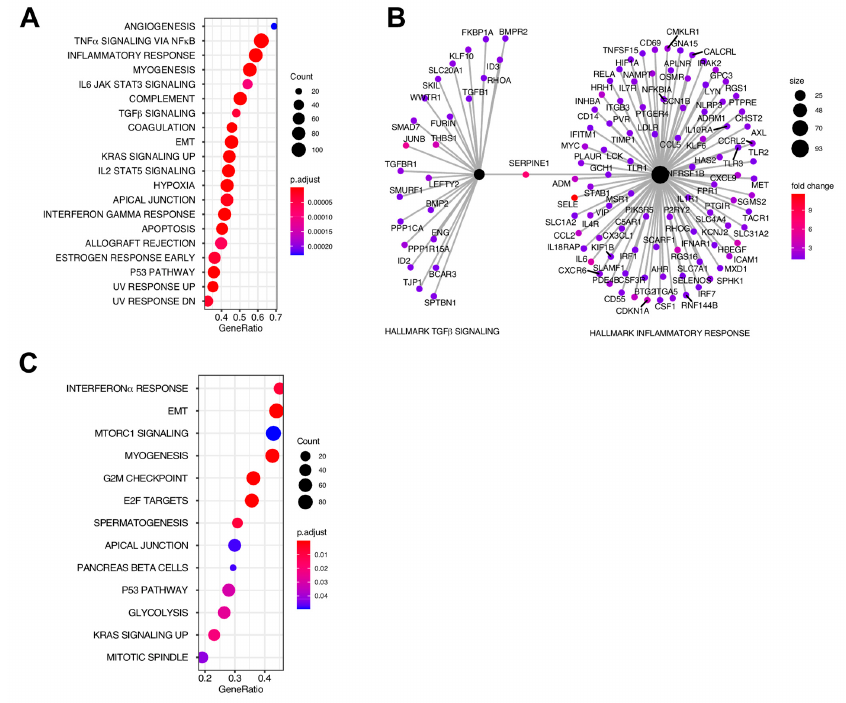
Figure 2. Gene set enrichment analysis (GSEA) of myometrial samples from non-fibroid patients (M) compared with myometrial samples from fibroid patients (MF) and with fibroids (F). ( A ) Top significantly enriched gene sets from the MF vs. M by GSEA using Hallmark biological processes in MSigDB. ( B ) Cnetplot of TGF β signaling and inflammatory response processes enriched gene sets in MF vs. M. SERPINE1 was in each set and is shown here connecting the two nodes. Fold change and number of genes in each node are indicated by the color gradient and circle size, respectively. ( C ) Significantly enriched gene sets (F vs. M) from GSEA using Hallmark biological processes in MSigDB. Gene count and significance level are shown by the size and color of each circle, respectively, in A and C.